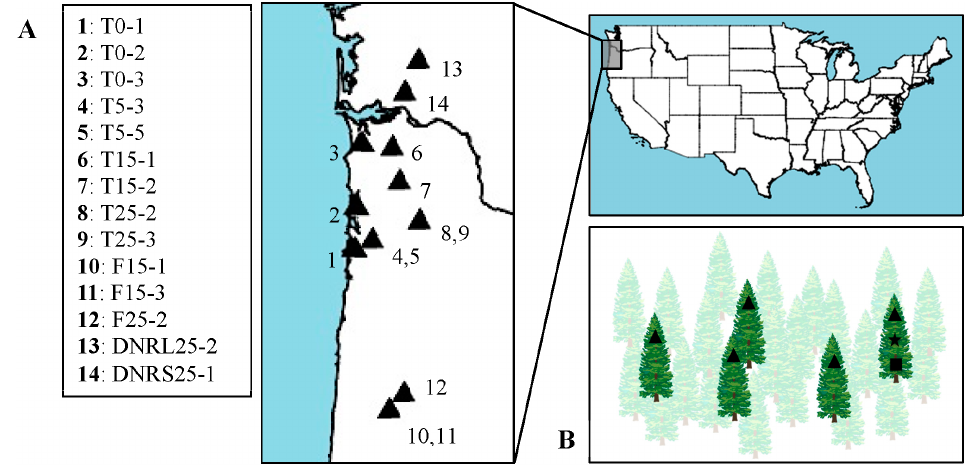
Figure 1. ( A ) Map of northwestern Oregon and southwestern Washington with markers indicating the locations of sites where Pseudotsuga menziesii foliage was collected for isolation of Phaeocryptopus gaeumannii . Legend at left shows the site names corresponding to marker numbers on map. T = Tillamook, F = Florence, DNR = Washington Department of Natural Resources. The number immediately following the letter corresponding to these locations represents the distance of the sampled stand from the coast. (ex: T25 = 25–35 miles (40–57 km) from coast at the latitude of Tillamook, Oregon); ( B ) Schematic diagram of foliage sampling at a given site. Triangles represent collections from the upper canopies of five randomly selected Douglas-fir trees at each site. The star and the square represent collections of foliage from the middle and lower canopy, respectively, of one of the five trees sampled at each site. Table 1. Sample sizes, genotypic richness, and lineage distributions determined for 482 P. gaeumannii isolates from the 14 sites sampled for this study.